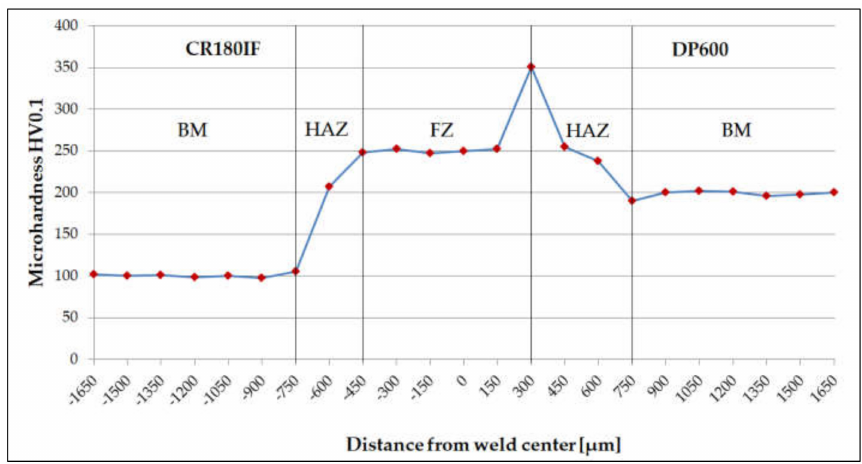
Figure 7. The microhardness distribution in base metal (BM), heat-affected zone (HAZ), and welded fusion zone